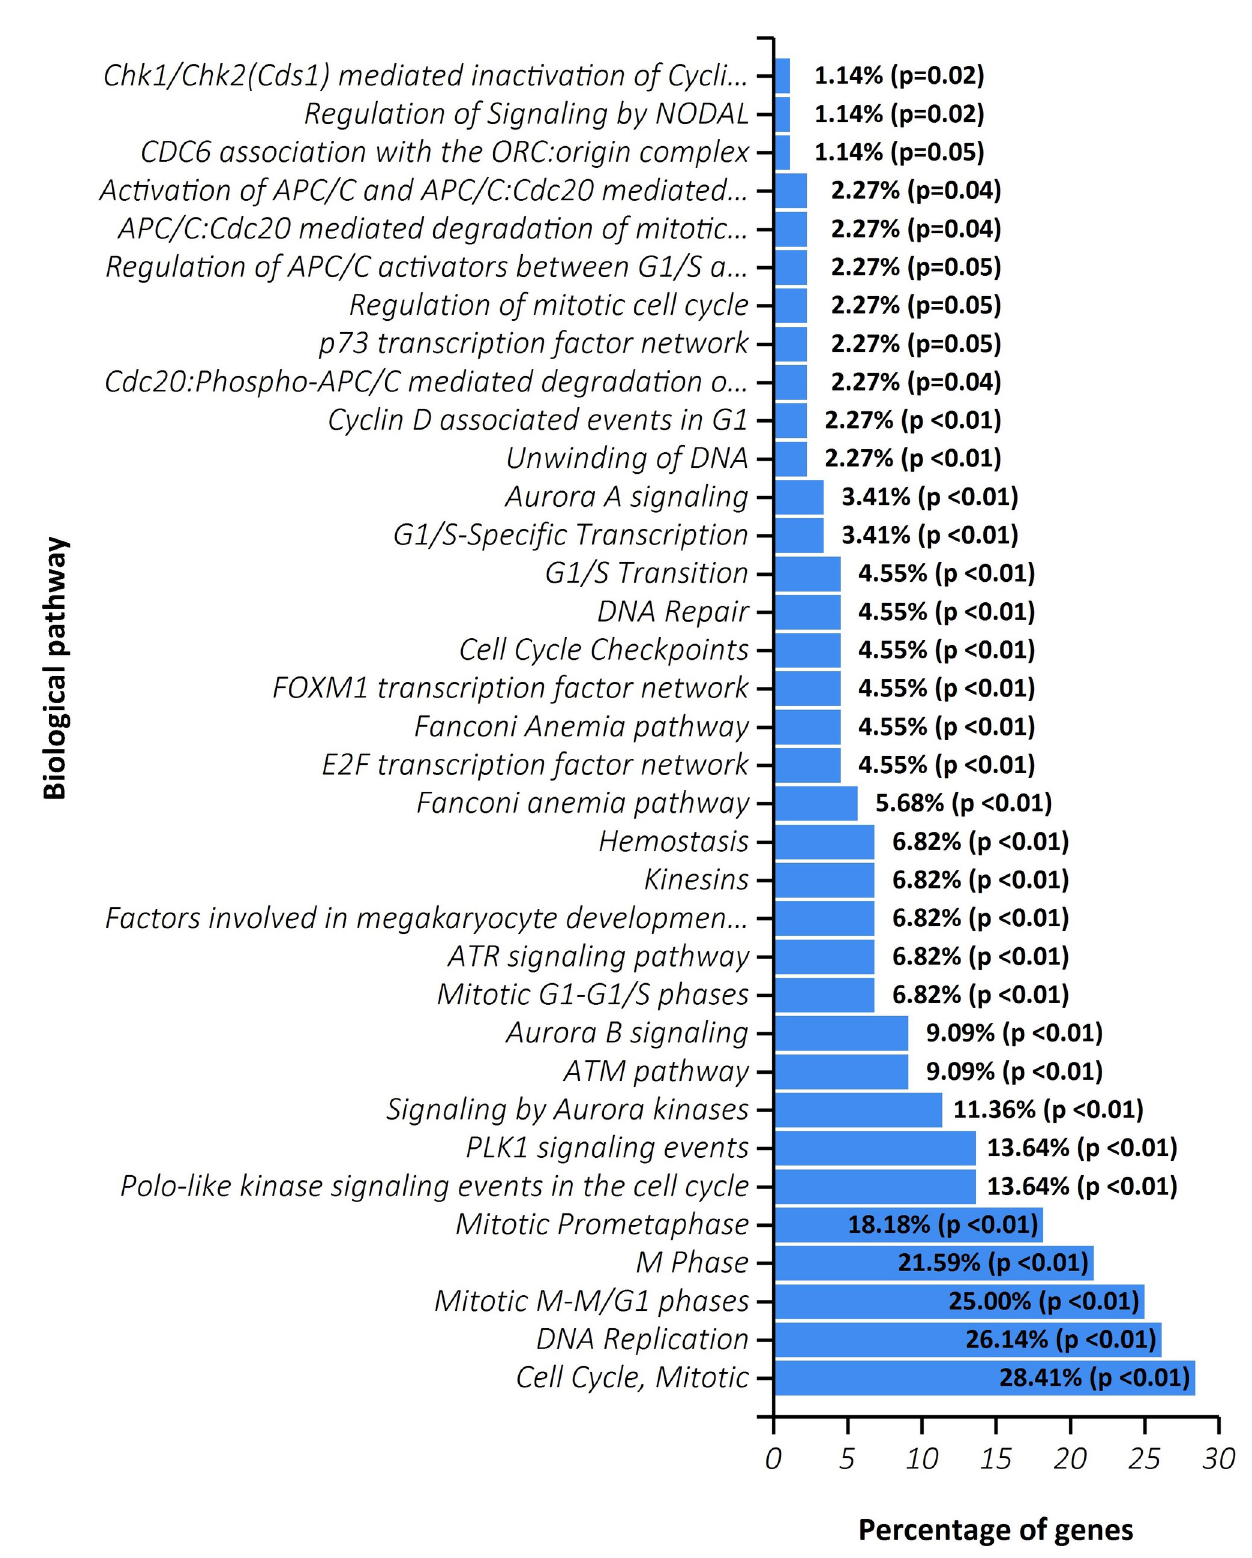
Fig 6. Pathway enrichment result of explored module around the seed gene ECT2.